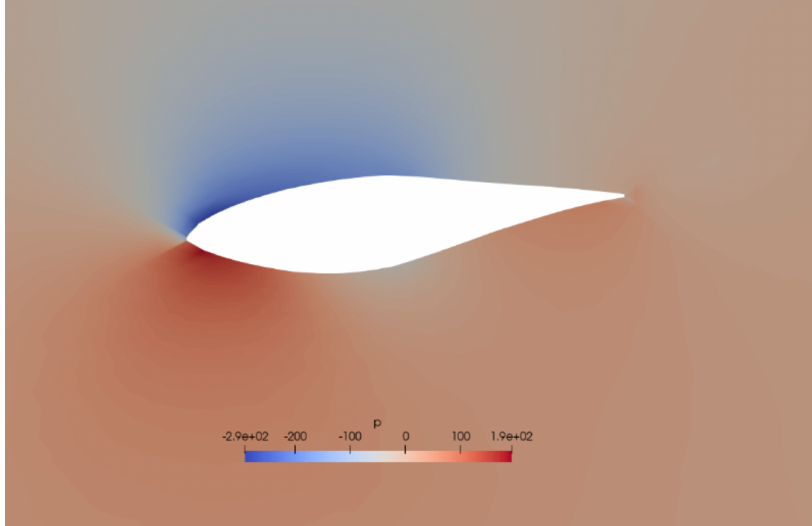
Figure 4. Pressure profile over airfoil at the 46.6% span of the